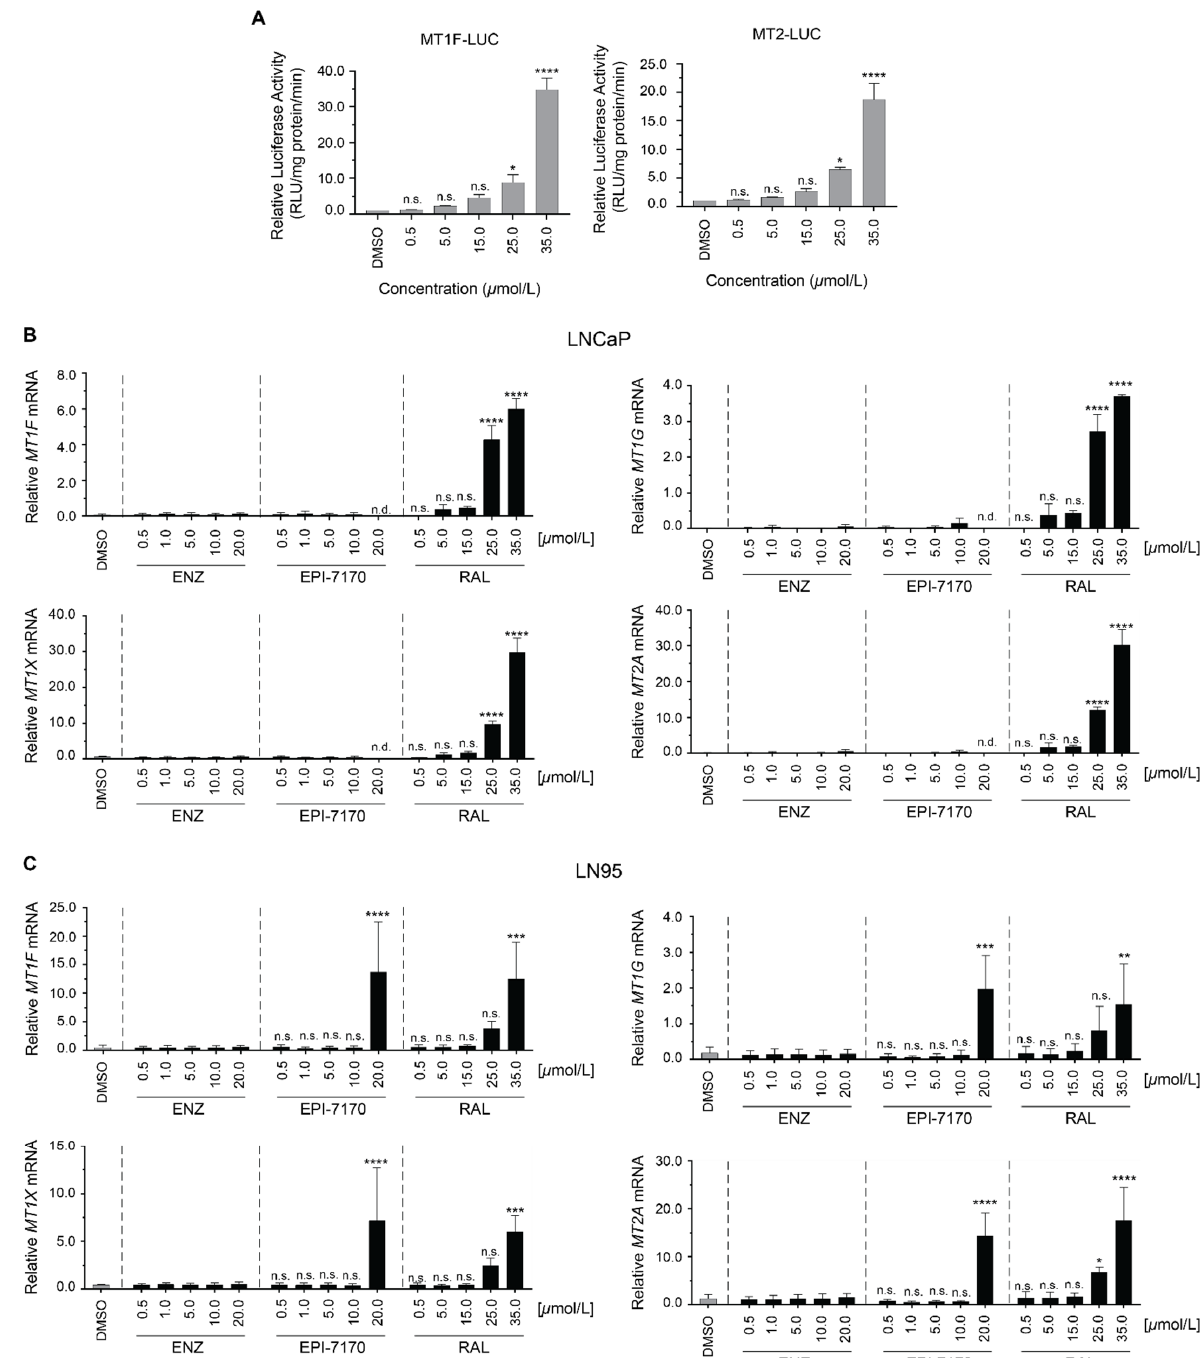
Figure 3. Induction of metallothionein gene expression by ralaniten is dependent on